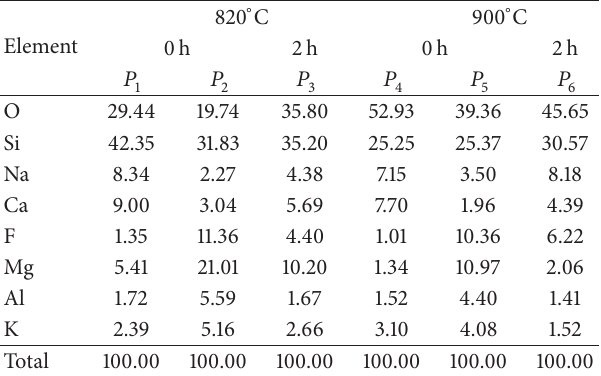
Table 2: Composition change of sandwich samples isothermally heated at 820 ∘ C and 900 ∘ C